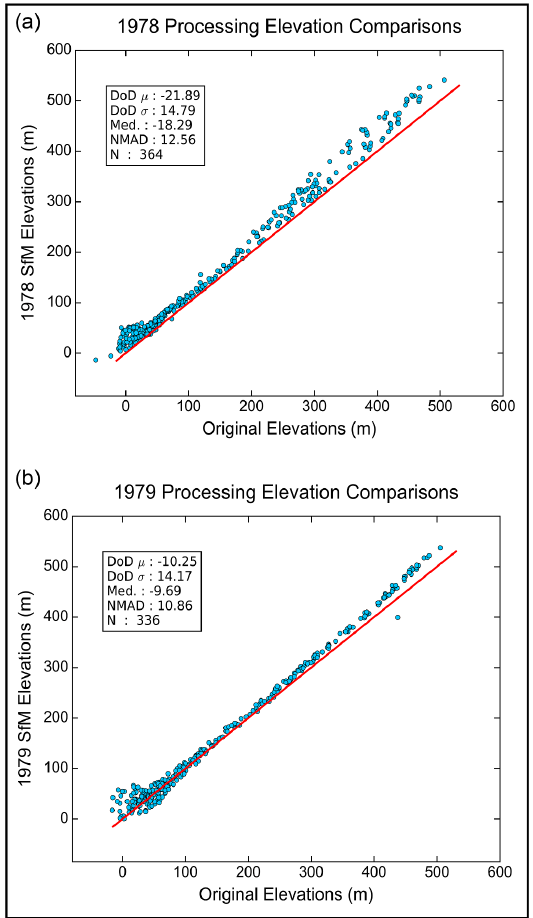
Figure 8. Scatter plots of the original analog elevation processing values with the SfM processing elevations (DEM of difference (DoD)) for 1978 ( a ) and 1979 ( b